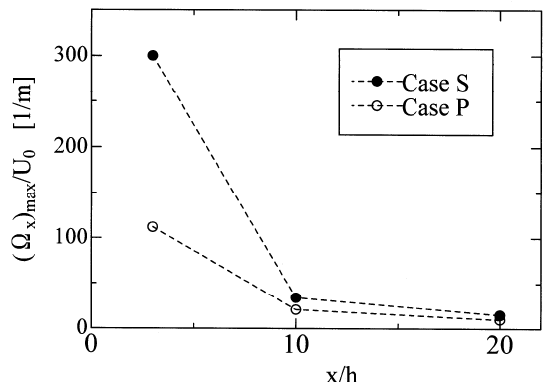
Fig.5 Decay of the maximum streamwi